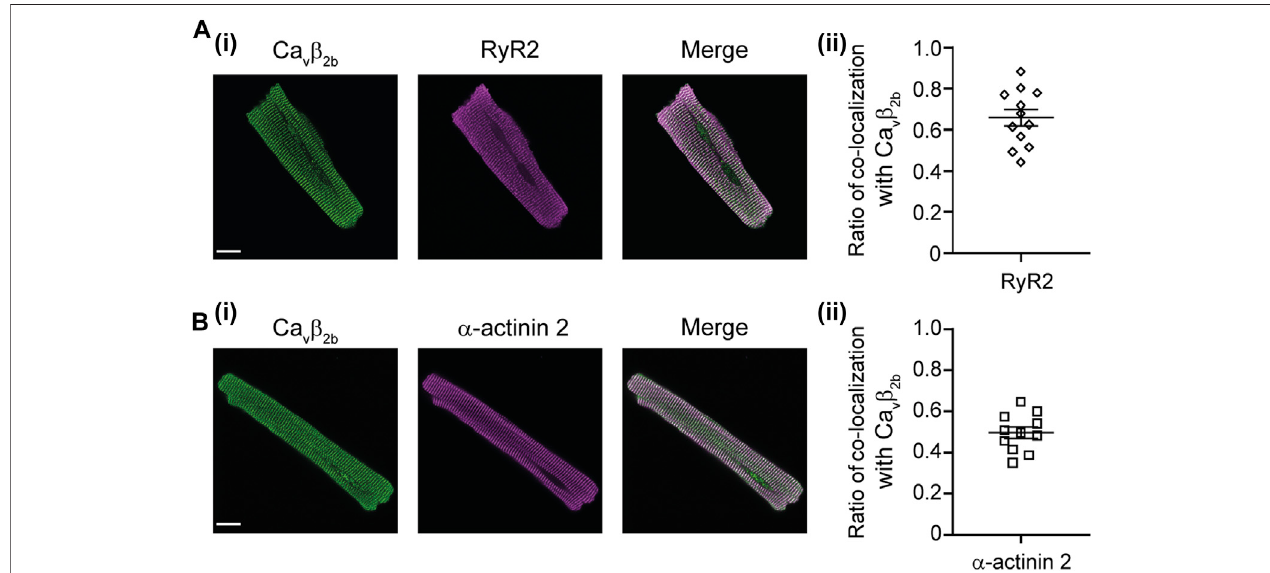
FIGURE 4 | Confocal images of immunostained ARCs. (A) Confocal images of a representative ARC stained with antibodies recognizing Ca v β 2b (green) and RyR2 (magenta) (i) and scatter plot showing ratio of co-localization of Ca v β 2b with the RyR2 ( n (cid:2) 12 cells), ( ii ). (B) Confocal images of a representative ARC stained with antibodiesrecognizing Ca v β 2b (green)and α -actinin2(magenta) (i) andscatter plotshowingratioofco-localizationofCa v β 2b with α -actinin 2( n (cid:2) 11cells),( ii ).Scalebars represent 15 µm. ARCs, adult rat cardiomyocytes; RyR2, ryanodine receptor 2.